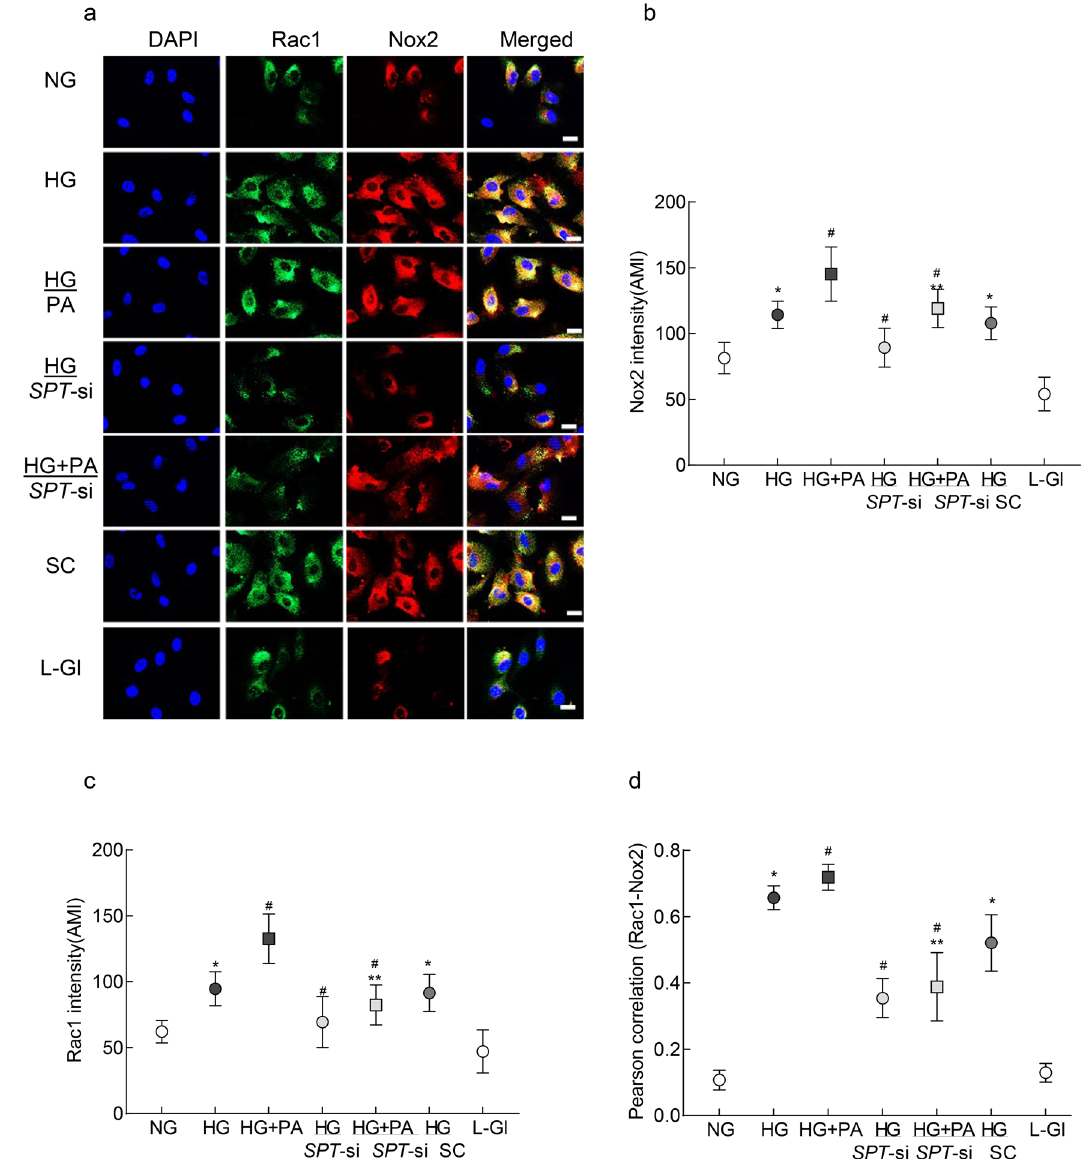
Figure 2. Rac1–Nox2 colocalization and inhibition of SPT. ( a ) Rac1 and Nox2 were determined by immunofluorescence using DyLight green (green)-conjugated and Texas Red (red)-conjugated secondary antibodies, respectively. The line marker represents 20µm. ‘Arithmetic mean intensity’ (AMI) of ( b ) Nox2 and ( c ) Rac1 was quantified by Zeiss software, from 5 to 8 images/group. ( d ) Zeiss software module was used to calculate Pearson’s correlation coefficient between Rac1 and Nox2. The values in the graph are mean ± SD, obtained from 3–4 different cell preparations with multiple cells analyzed in each preparation. *p < 0.05 vs NG, # p < 0.05 vs HG and # **p < 0.05 vs HG + high fat-low dose streptozotocin, type 2 diabetic mice (HF-SD group). However, compared to Diab group, the HF-SD group showed significantly higher severity of impairment in glucose utilization (p < 0.05; Fig. 5a). Com- pared to the Diab group (22.8 ± 3 g) or Norm group (26.9 ± 2 g), the body weights of mice, measured at the time of glucose tolerance test, were significantly higher in HF-SD group (48.5 ± 6 g, p < 0.05). Serine palmitoyl‑transferase. Compared to the Norm group, SPT gene transcripts were significantly elevated in mice in the Diab and HF-SD groups (p < 0.05 vs Norm), however, increase in SPT in the HF-SD group was higher compared to Diab group (p < 0.05 vs Diab; Fig. 5b). Administration of SPT -siRNA soon after induction of diabe- tes prevented an increase in SPT in diabetic mice on normal diet or high fat diet (Diab/ SPT -si and HF-SD/ SPT -si groups, respectively), and the values in these two groups were not different from those obtained from mice in Norm group (p > 0.05 vs Norm). Figure 5c shows transfection efficiency of SPT -siRNA with > 60% reduction in SPT gene transcripts in the retinal microvessels from normal mice receiving intravitreal injection of SPT -siRNA.